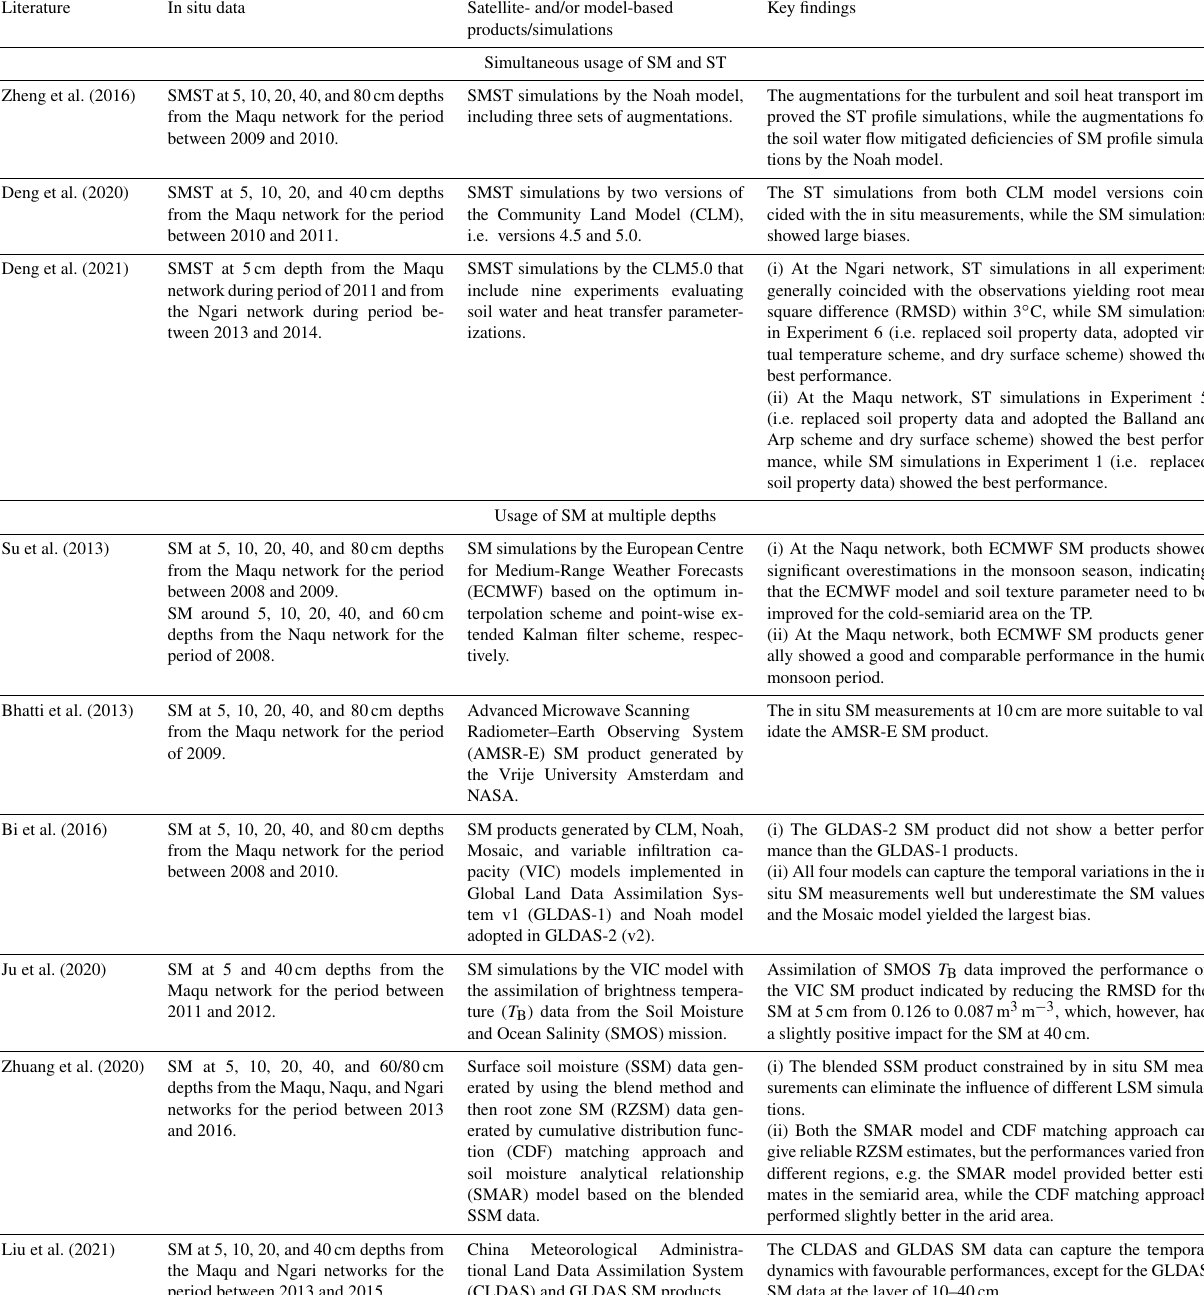
Table 1. Summary of the applications of the Tibet-Obs SMST data and the corresponding findings.